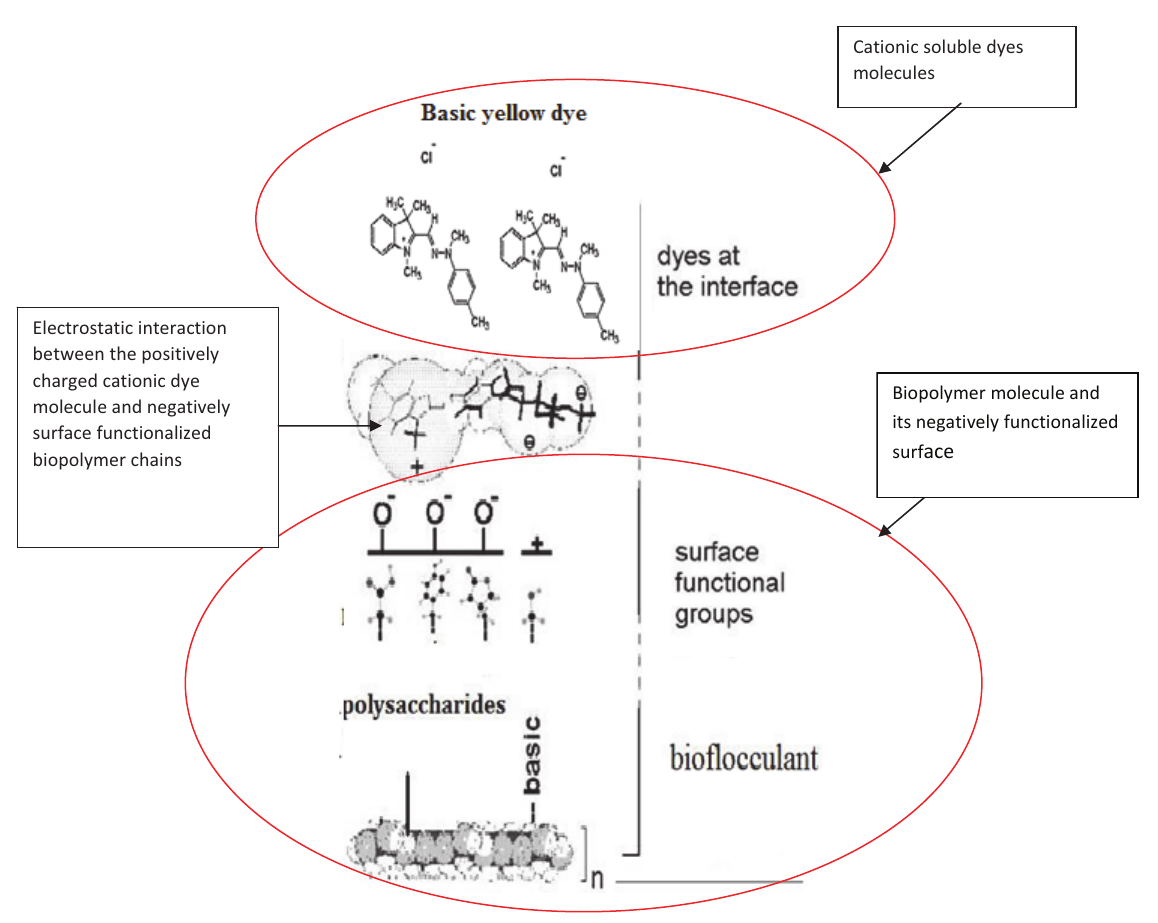
Fig. 3 – Model depicting the interaction between cationic dye molecules and biopolymer